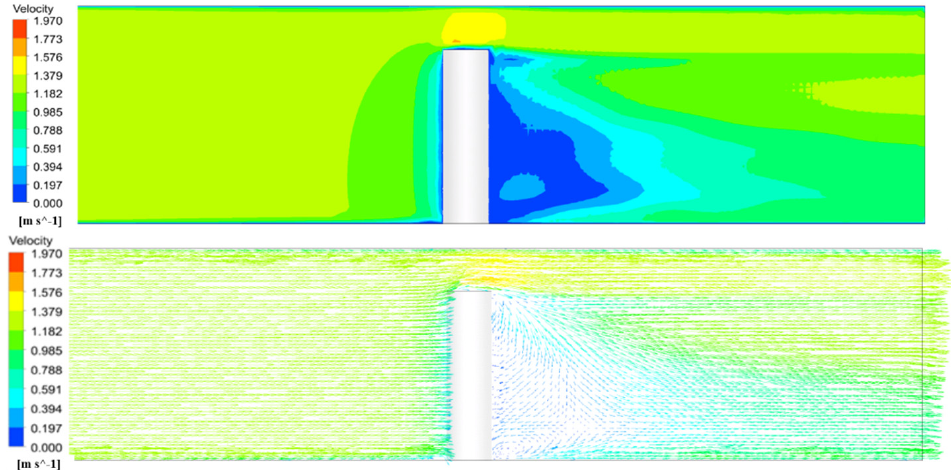
Figure 7. Velocity vector profile of the cylinder in the y–z plane (x = 0 m).